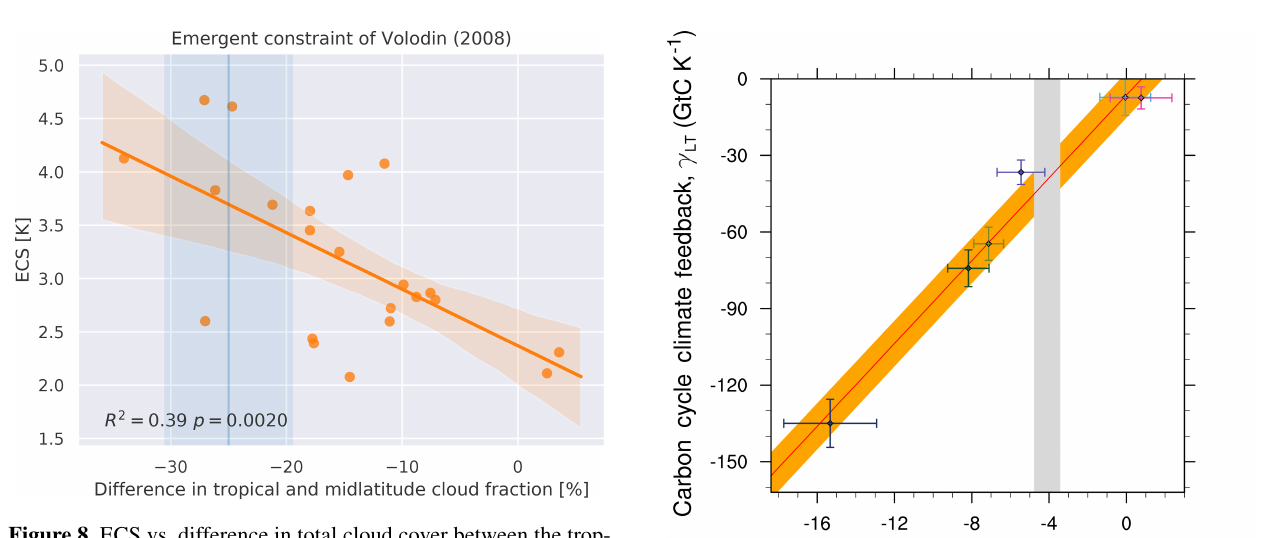
Figure 8. ECS vs. difference in total cloud cover between the trop- ics (28 ◦ S–28 ◦ N) and southern midlatitudes (56–36 ◦ S) for CMIP5 models (orange dots). The orange line and shaded area show the linear regression line and its 95% uncertainty range (estimated via bootstrapping). Together with the observational estimate (vertical blue line and shaded area), this can be used as an emergent con- straint for ECS (Volodin, 2008). The observational range is based on ISCCP-D2 data (Rossow and Schiffer, 1991) and taken from Volodin (2008). Similar to Fig. 3a of Volodin (2008) and produced with recipe_ecs_constraints.yml (see details in Sect. 3.3.1, “Differ- ence between tropical and midlatitude cloud fraction”).